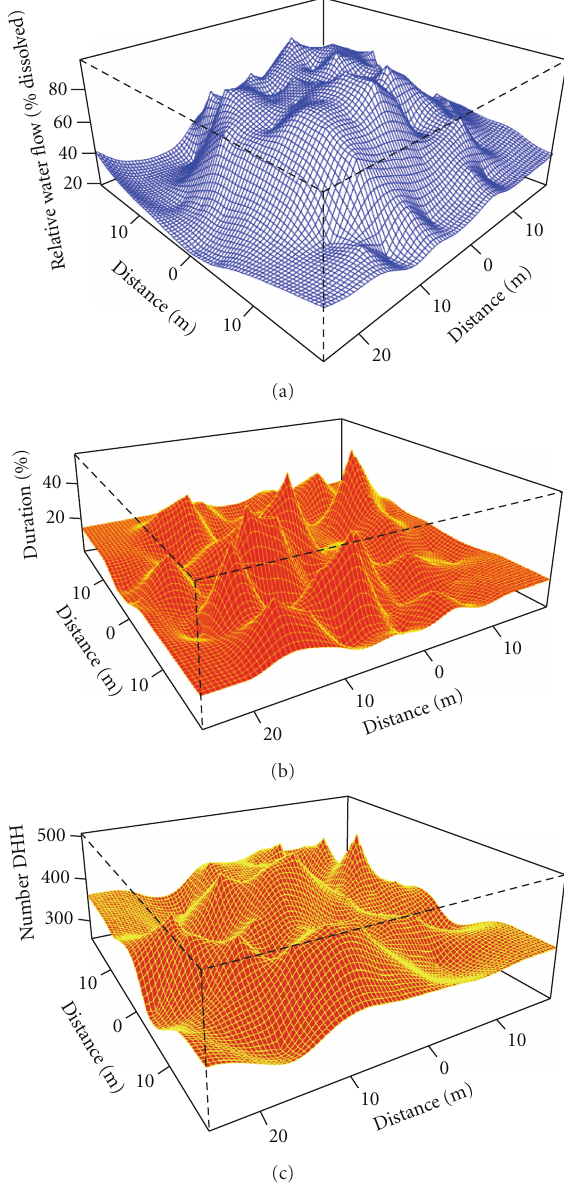
Figure 5: Ordinary kriging interpolation of water flow (a), percent of time spent as a relative Hotspot over two years (b), and number of Degree Heating Hours for Summer 2008 (c).